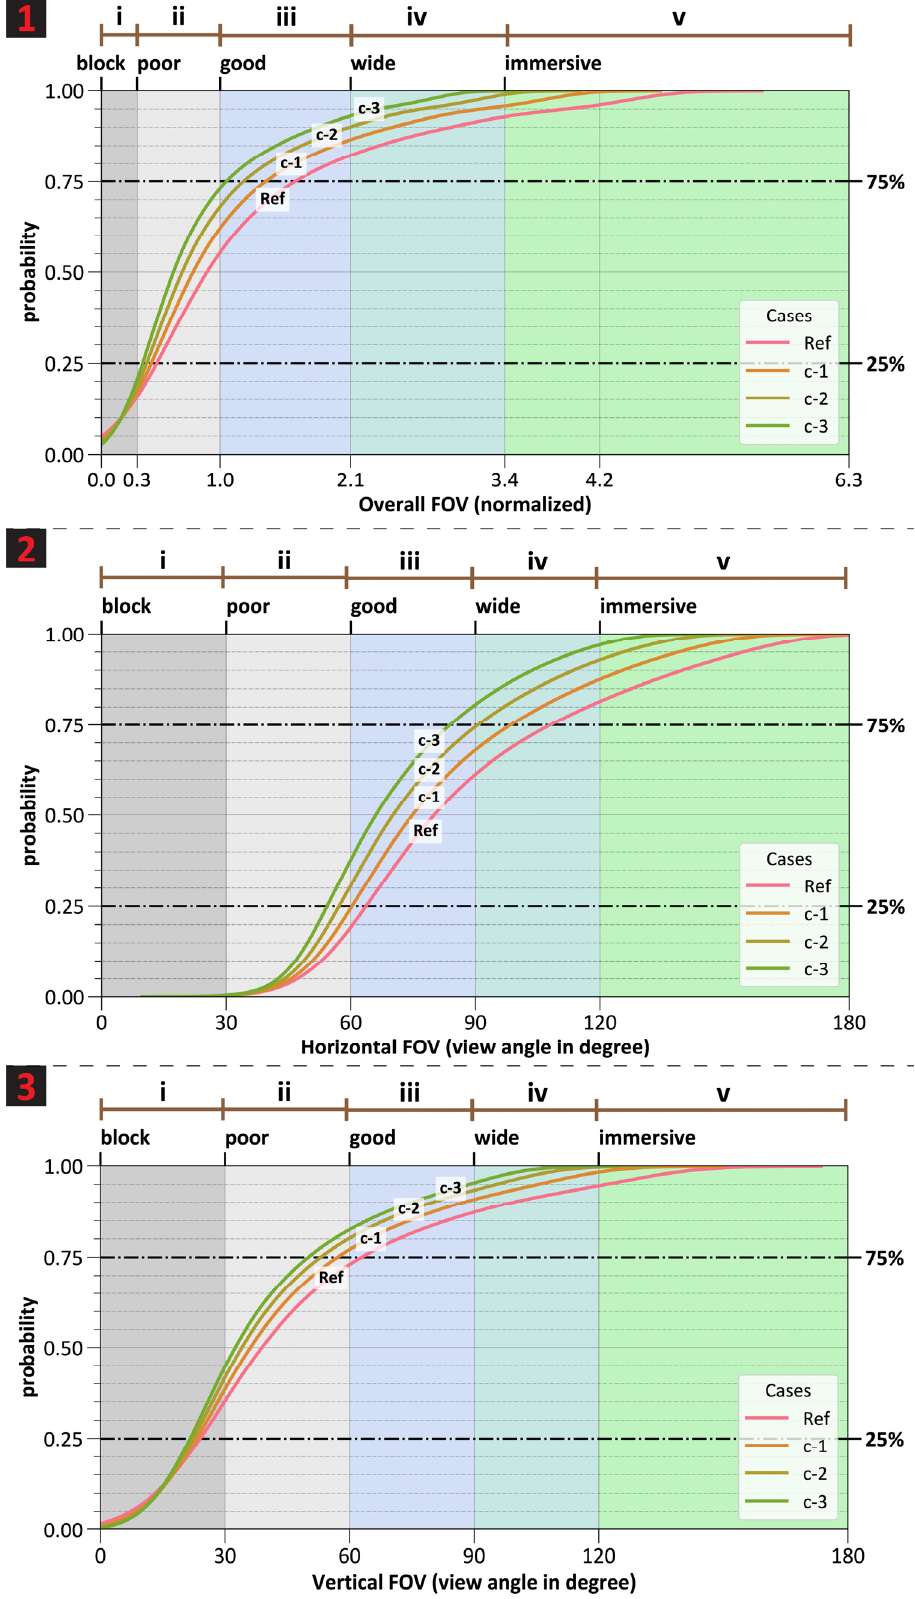
Figure 15. Impacts of external overhangs installed around window edges on the cumulative proba- bilities of overall, horizontal, and vertical FOVs for case studies of scenario-c.